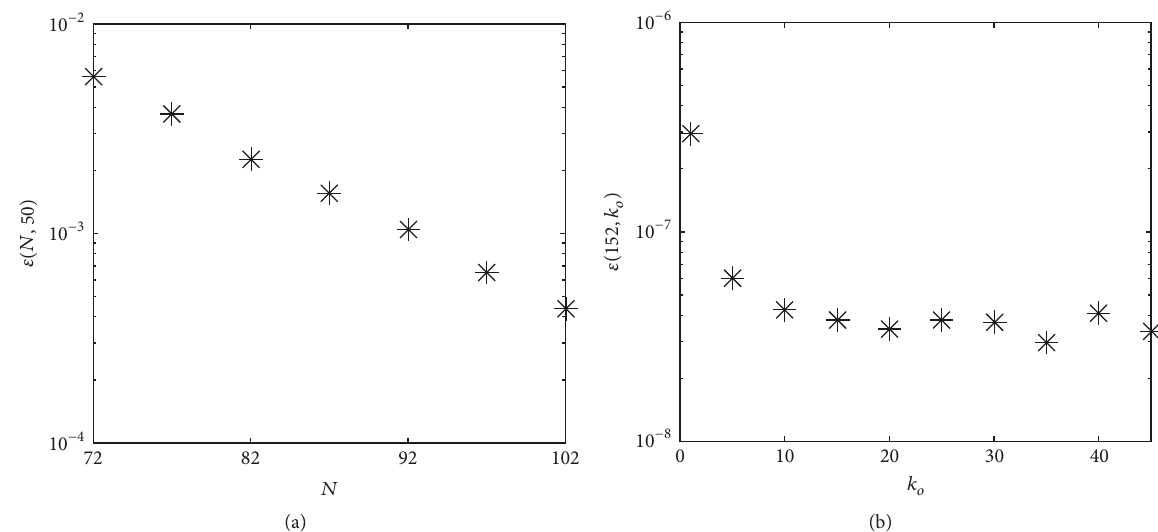
Figure 5: Relative error of the free system response estimated future value using different (a) 𝑁 and (b) 𝑘 𝑜 for the forced vdP oscillator.